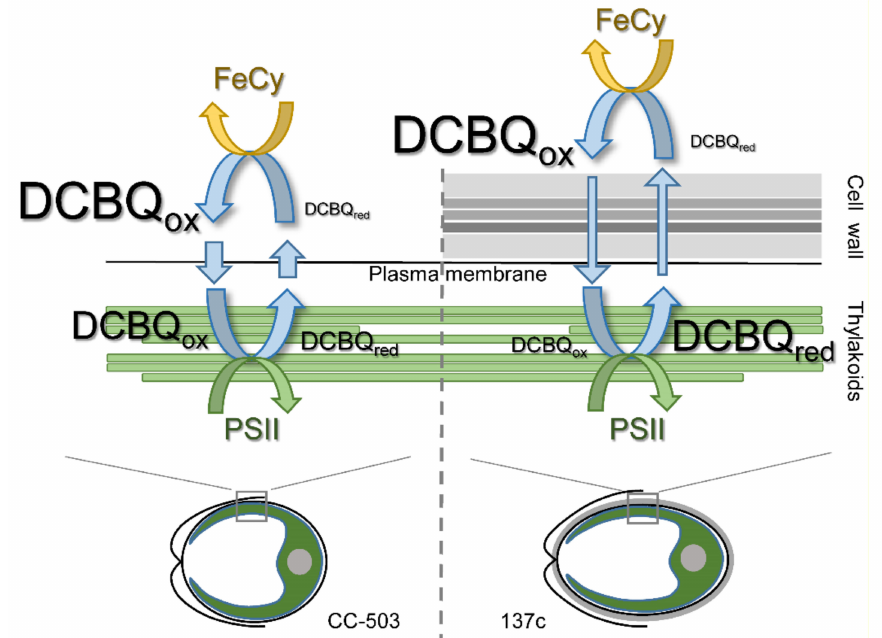
Figure 6. A scheme of the proposed cycle of DCBQ molecules diffusion in living cells of C. reinhardtii without (CC-503) and with (137c) a cell wall. Actions of PSII in the chloroplast and extracellular FeCy in the cycle are indicated by green and yellow arrows, respectively. The thickness of the straight blue arrows reflects the difference in diffusion efficiency of DCBQ molecules moving inside the cell and going back. The sizes of the “DCBQ” writing indicate possible differences between the contents of the oxidized (ox) and reduced (red) forms of DCBQ, respectively, inside and outside the algal